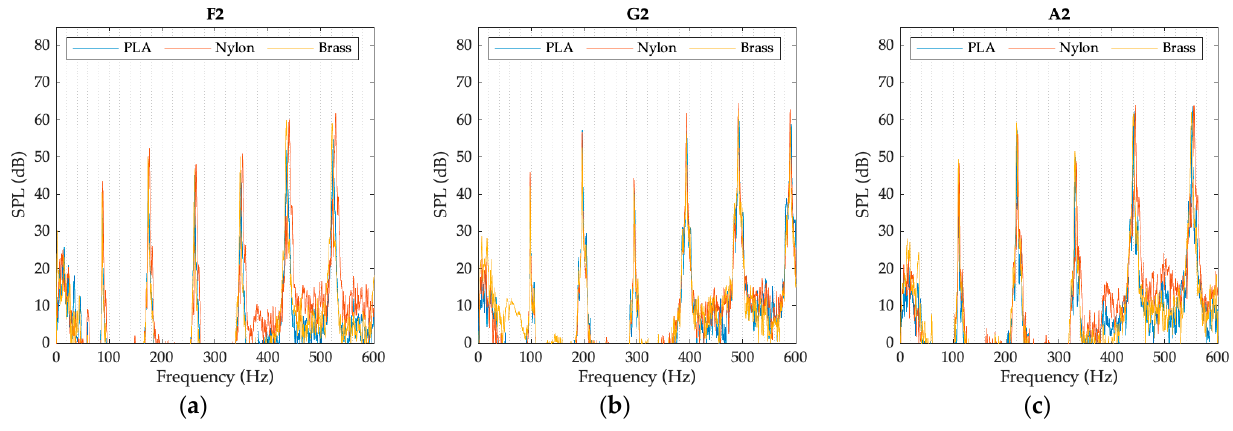
for the N mouthpieces. The deviation between frequencies was calculated for each harmonic of each note.